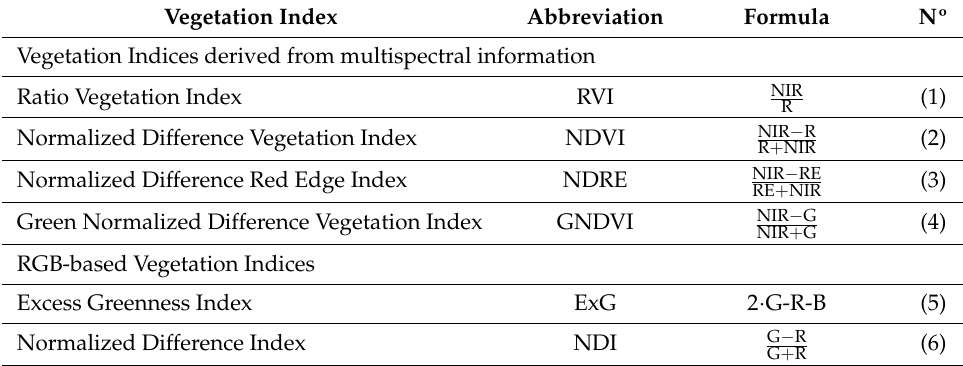
Table 1. Most applied vegetation